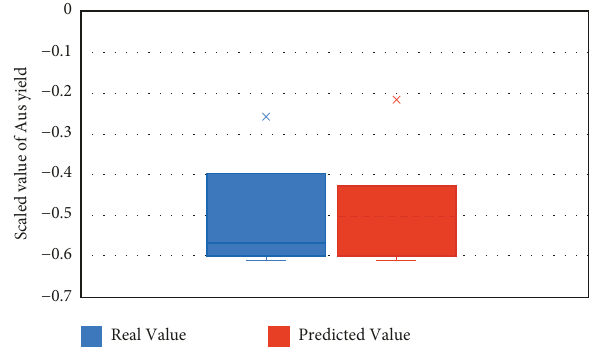
Figure 11: Comparison between Real Values and Predicted Values of Aus yield for SVR using box plot. Table 3: RMSE and r 2 value after Aus yield prediction.